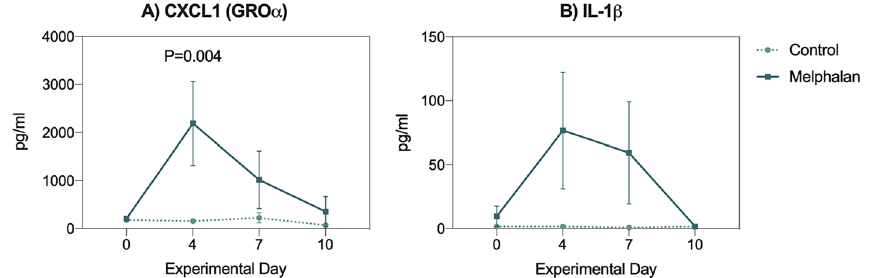
Figure 1. Melphalan causes hyperactivation of the CXCL1 (GROα) / IL-1β axis in rats. ( A ) CXCL1 and ( B ) Il-1β were assessed in repeated blood samples collected after melphalan treatment. Data presented as mean ± SEM. N = 8/group, all analyzed longitudinally using a mixed-effects model with Geisser-Greenhouse correction for multiple